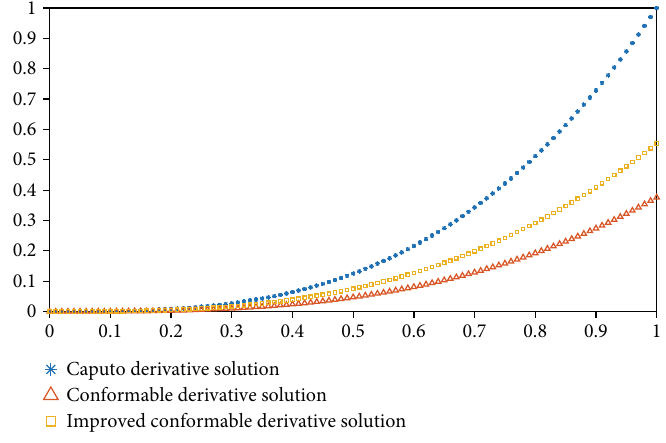
Figure 11: Solution of Example